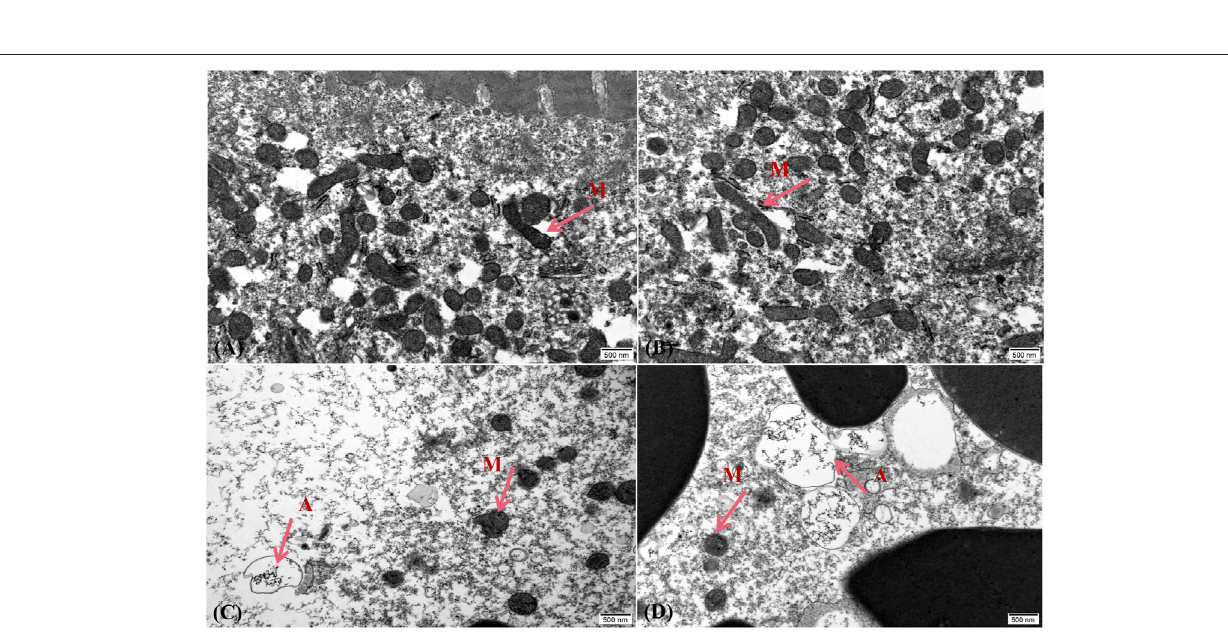
Frontiers in Physiology |